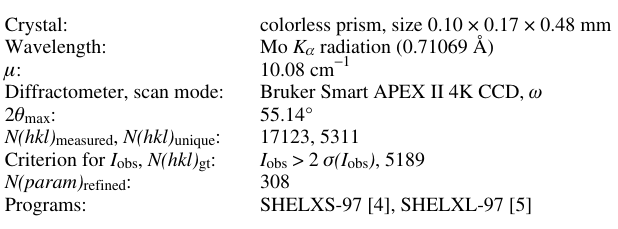
Table 1. Data collection and